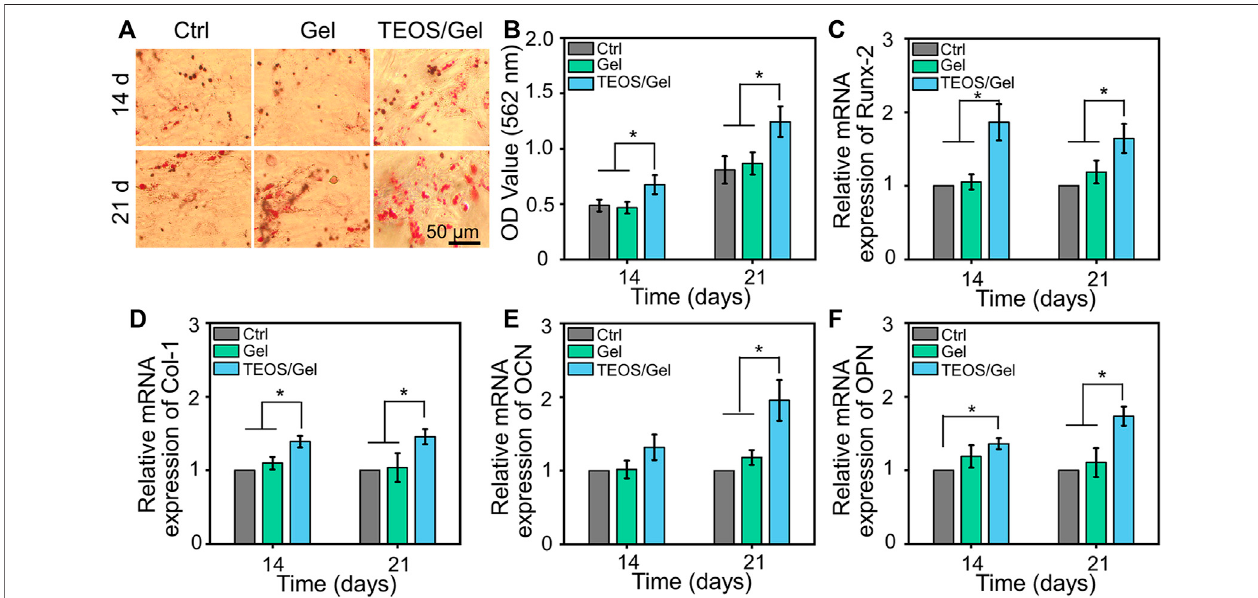
FIGURE 3 | TEOS hydrogel induces BMSC osteogenic differentiation. (A) Gross images of Alizarin Red staining. (B) Semi-quantitative analysis of Alizarin Red staining. (C – F) mRNA expression levels ofosteogenic-related genes, including Runx-2 , Col-1 , OCN , and OPN , in BMSCsafter osteogenic induction for14 and 21 days (* p < 0.05).